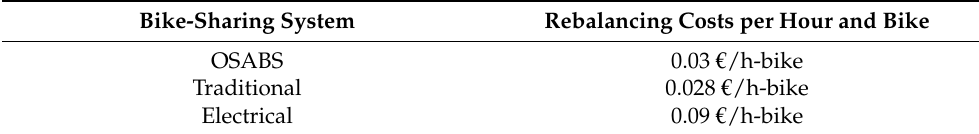
Table 8. Comparison of rebalancing costs of different bike-sharing